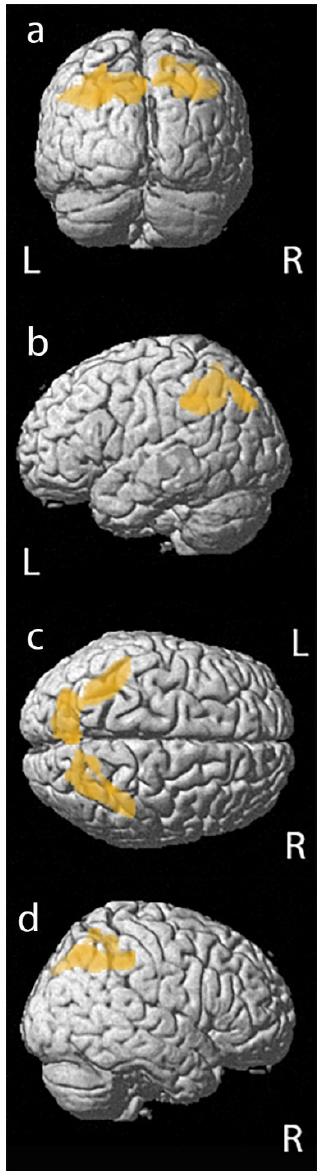
Figure 2. 3D rendering of the results of statistical parametric mapping analyses between (18F)FDG uptake and performance in RCFT copy that shows a positive correlation in left and right Brodmann area 40 and left and right Brodmann area 7: ( a ) posterior view; ( b ) left lateral view; ( c ) superior view; ( d ) right lateral view.